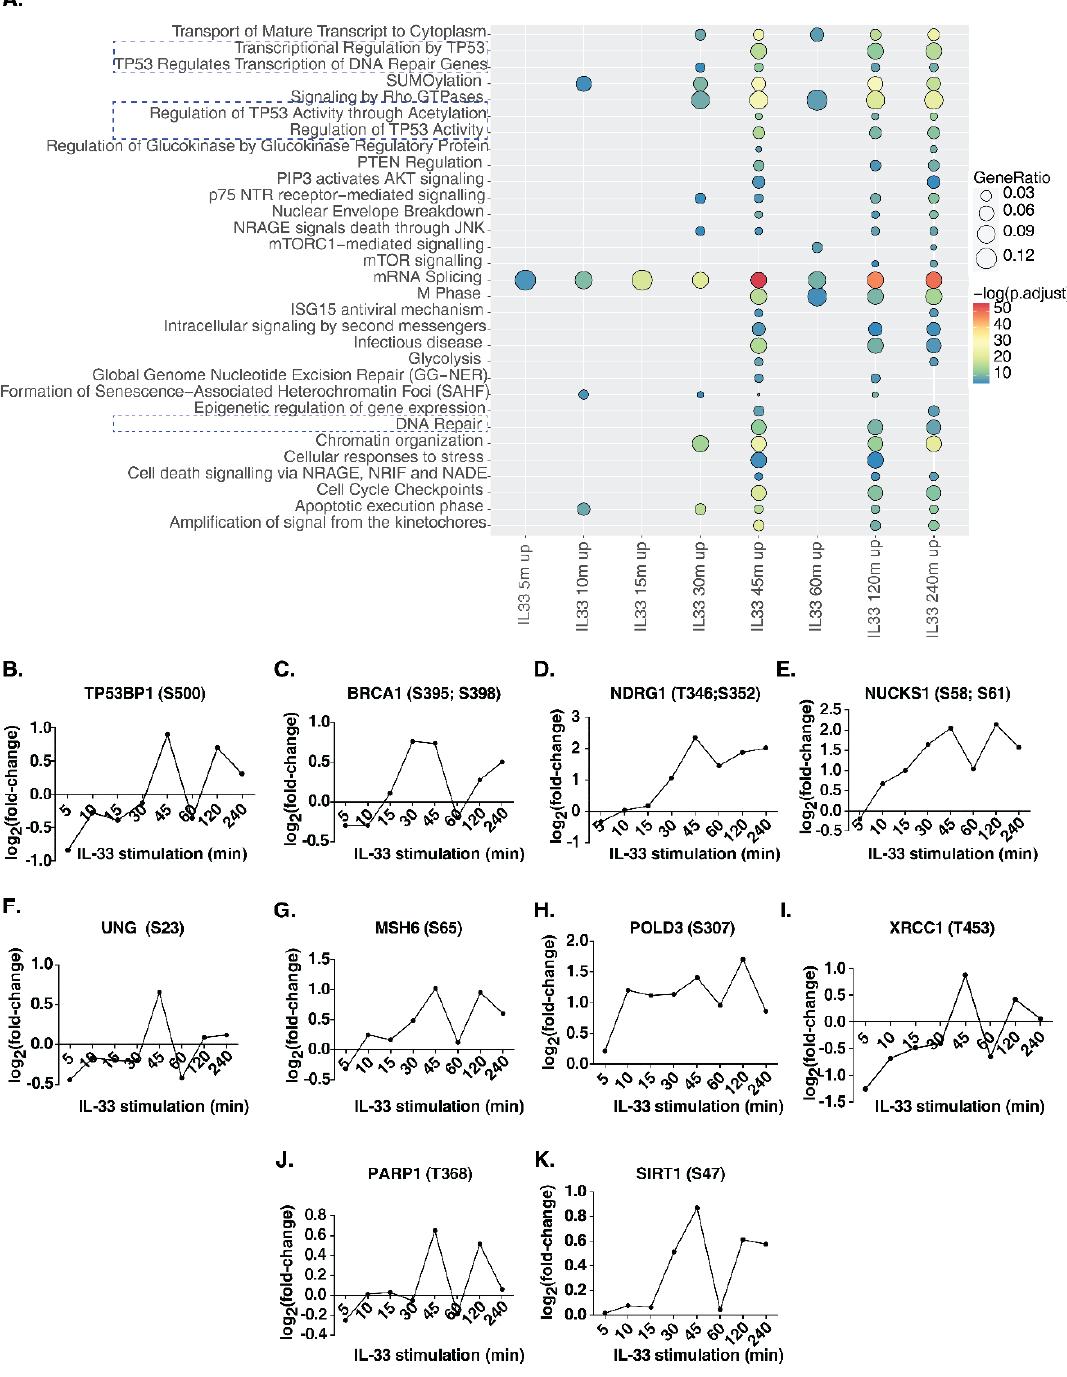
Figure 4. ( A ) Reactome pathway analysis of upregulated phosphoproteins showed induction of several signaling pathways including DNA damage and DNA repair pathways (highlighted with dotted lines). Further detailed analysis identified specific phosphosite changes in several DNA damage/repair proteins including ( B ) TP53BP1, ( C ) BRCA1, ( D ) NDRG1, ( E ) NUCKS1, ( F ) UNG, ( G ) MSH6, ( H ) POLD3, (I) XRCC1, ( J ) PARP1 and ( K ) SIRT1.